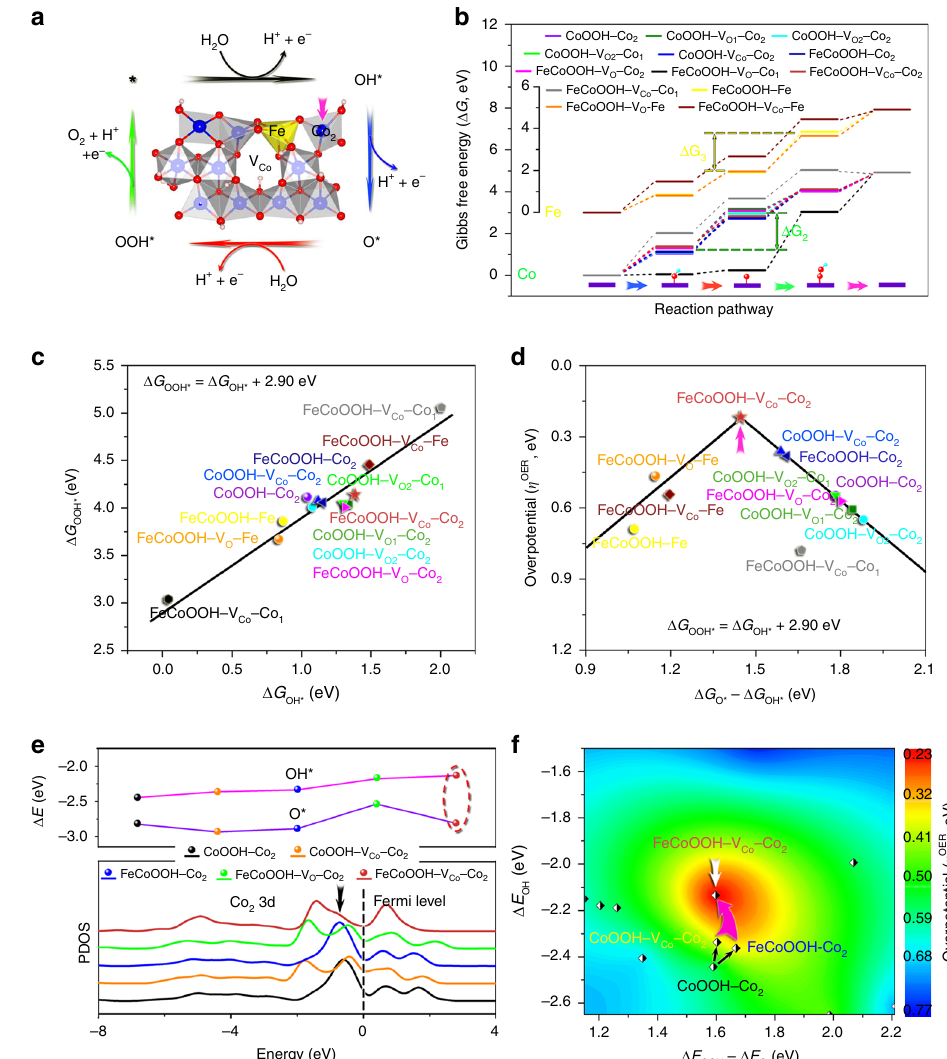
Fig. 4 Hubbard-corrected density functional theory calculations of catalytic activities of different surface metal sites. a Crystal structure of FeCoOOH – V Co and oxygen evolution reaction reaction pathway on (01-12) facet. b Gibbs free energy pro fi les along the reaction pathway. c Scaling relation between Δ G OOH* and Δ G OH* . d Volcano plot of overpotential as a function of Δ G O* − Δ G OH* based on the scaling relation. e Calculated partial density of states (PDOS) of Co 2 sites and binding energies of OH* and O*. f Contour plot of theoretical overpotential as a function of Δ E OOH − Δ E O and Δ E OH , indicating the near-optimal intermediate binding energies achieved by Fe doping and Co